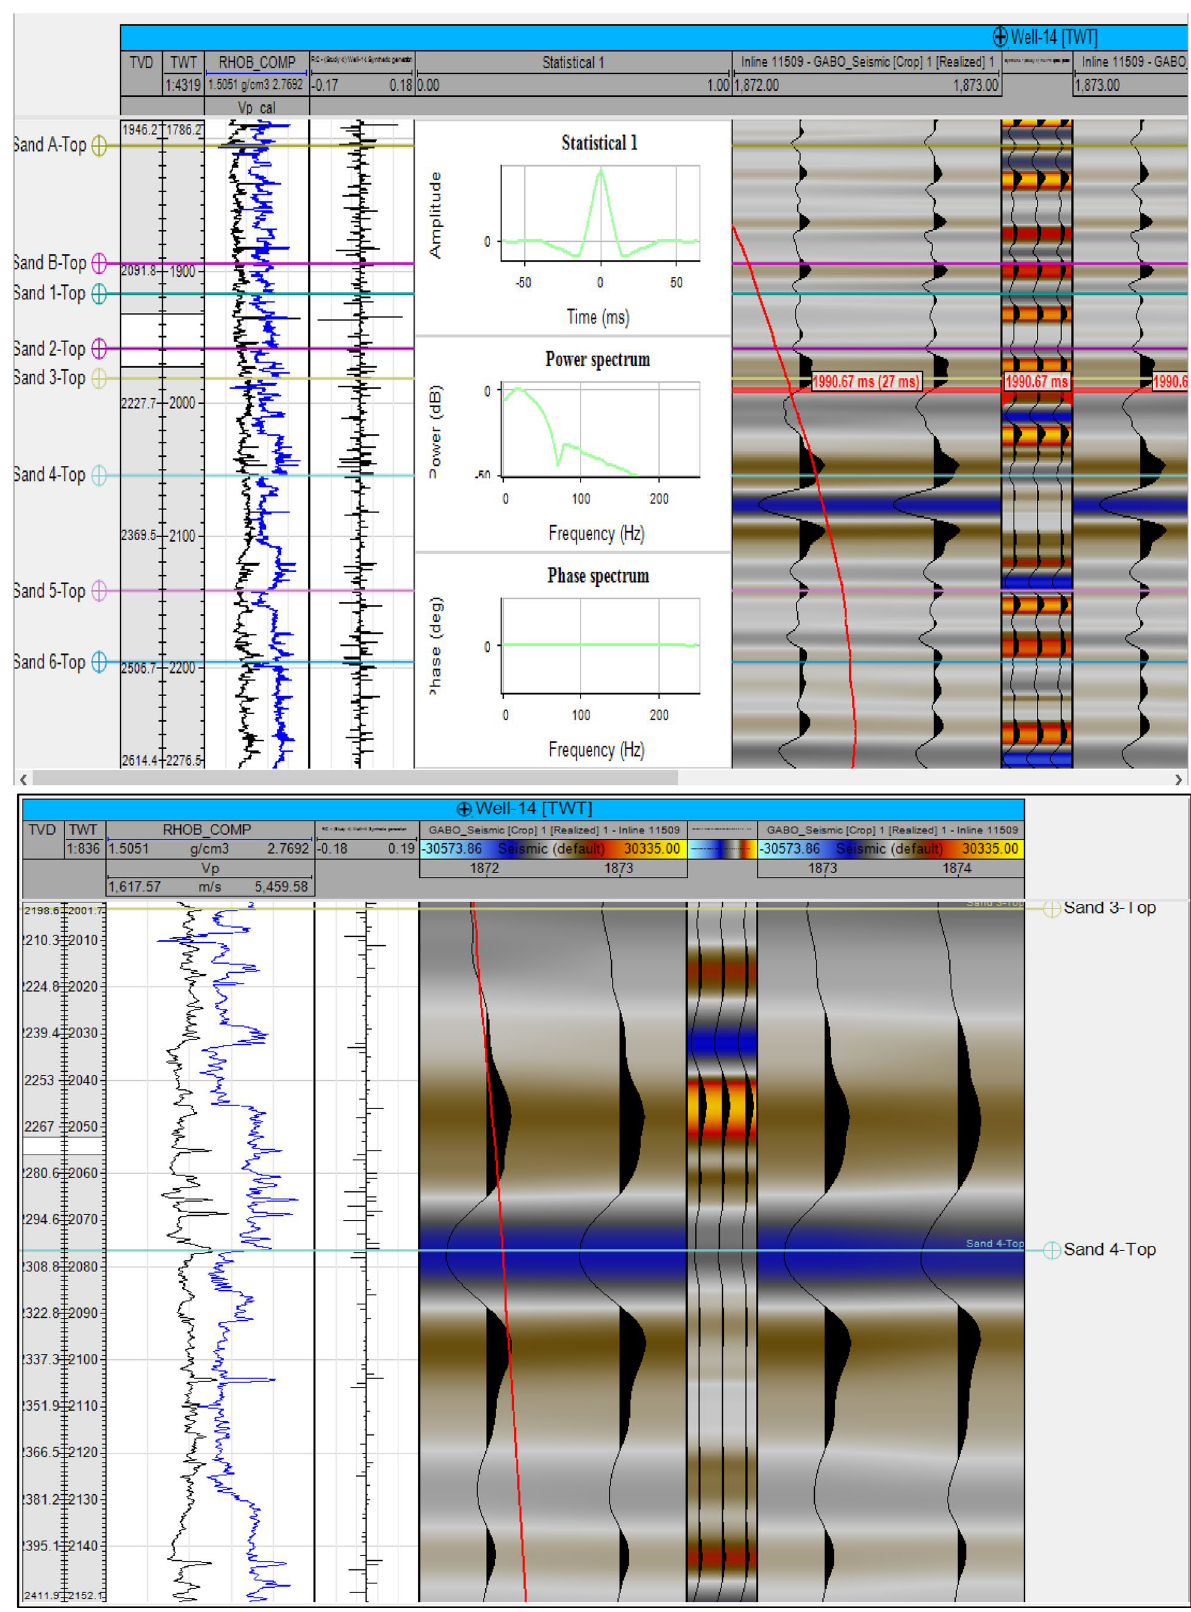
Fig. 5 Seismic to well tie (well